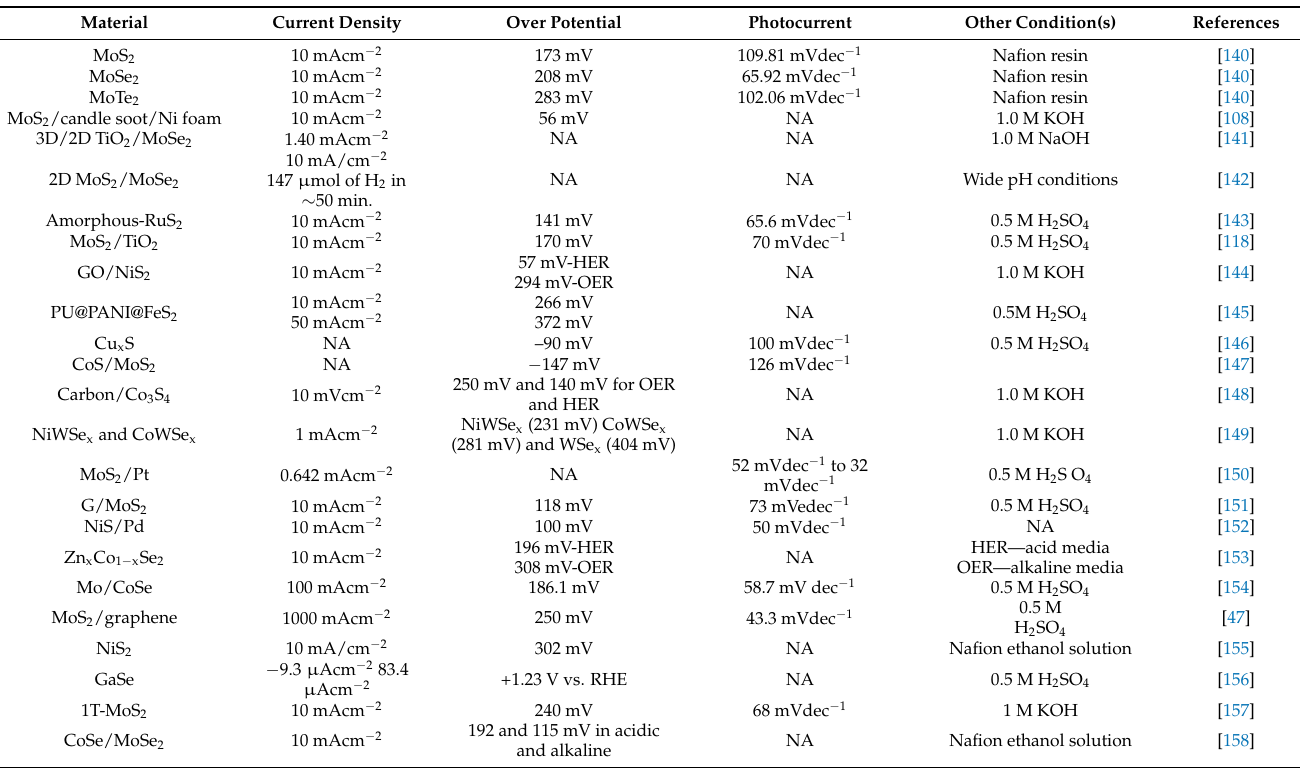
Table 3. Comparison of electrochemical hydrogen evolution by using different TMC photocatalysts. Material Current